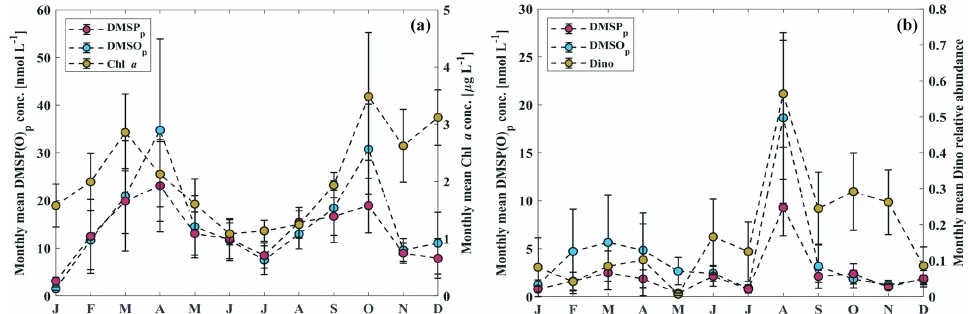
Figure 6. (a) Monthly mean DMSP p , DMSO p and Chl a concentrations in the mixed layer during 2009–2018 at BE. (b) Monthly mean DMSP p , DMSO p concentrations and relative abundance of dinoflagellates at 25m during 2009–2018 at BE. Error bars represent standard errors of the mean of the